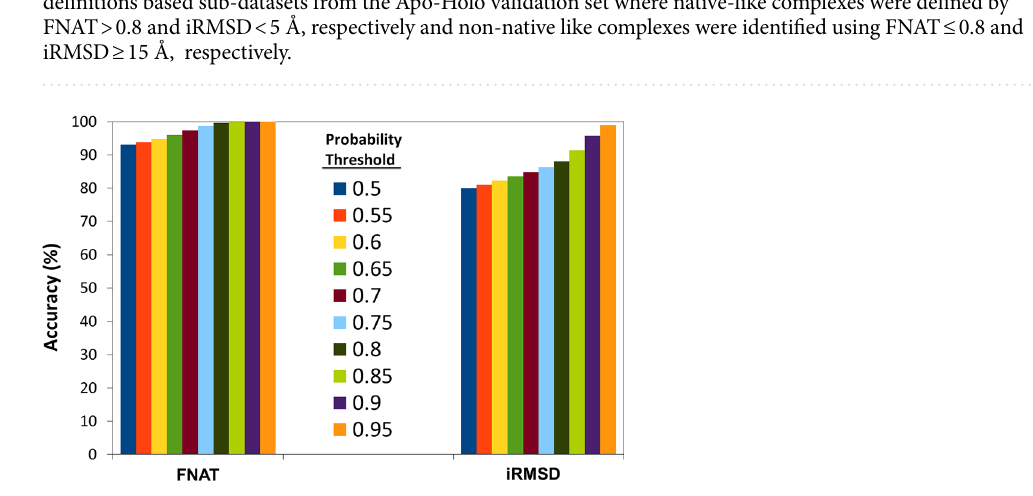
Figure 3. Verification of prediction accuracy. Percentage of correctly predicted non-native hetero complexes extracted from the Negatome dataset using both FNAT and iRMSD definitions are plotted. Accuracies are plotted as bar diagram for each probability threshold cutoff marked by different